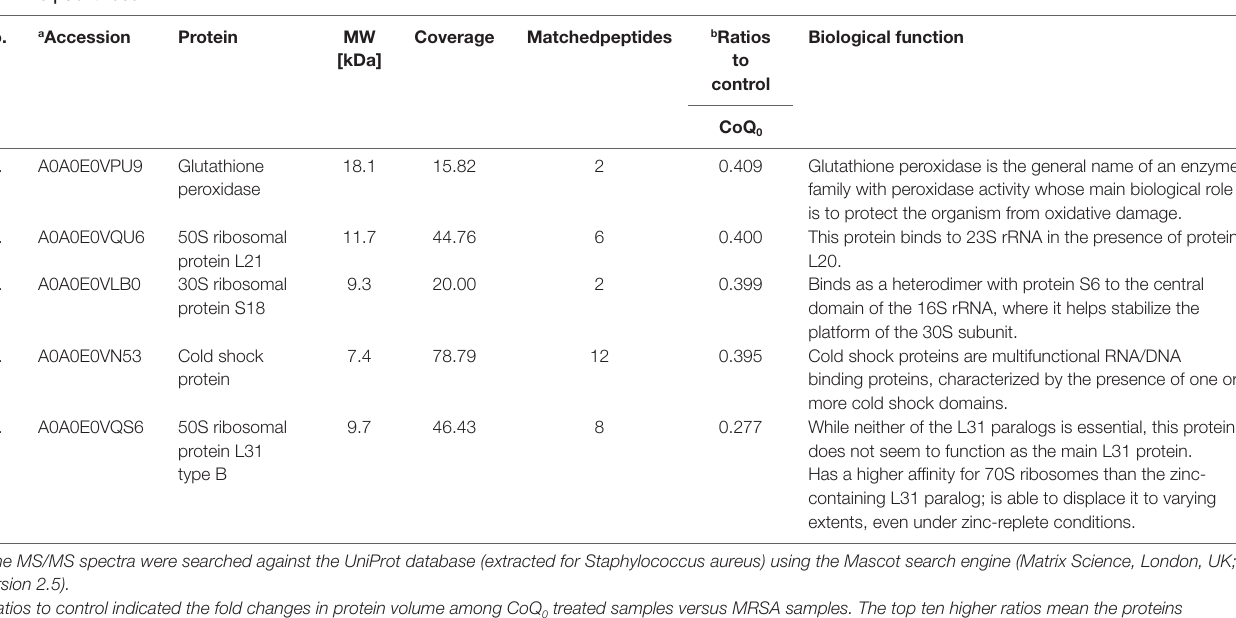
Based on histological evaluation as shown in Figure reduced these symptoms. OVA-induced AD exhibited 5G , the skin infected with MRSA exhibited the features of hyperkeratosis, hypertrophy, and a thicker epidermis in the increased epidermis thickness and inflammatory infiltrate in microscopic image. These symptoms were also visualized the dermis. CoQ treatment on the infected skin significantly in the OVA/MRSA group accompanied with immune-cell 0